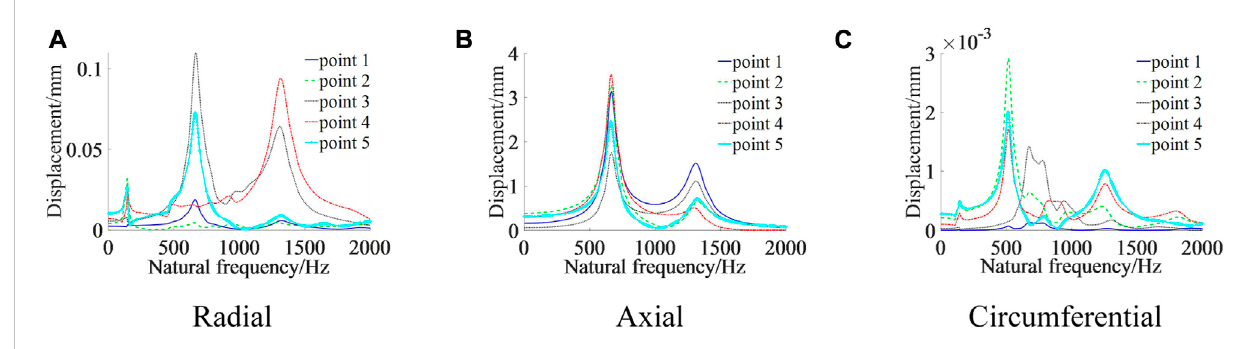
FIGURE 15 Displacement – frequency curve of the measurement point.